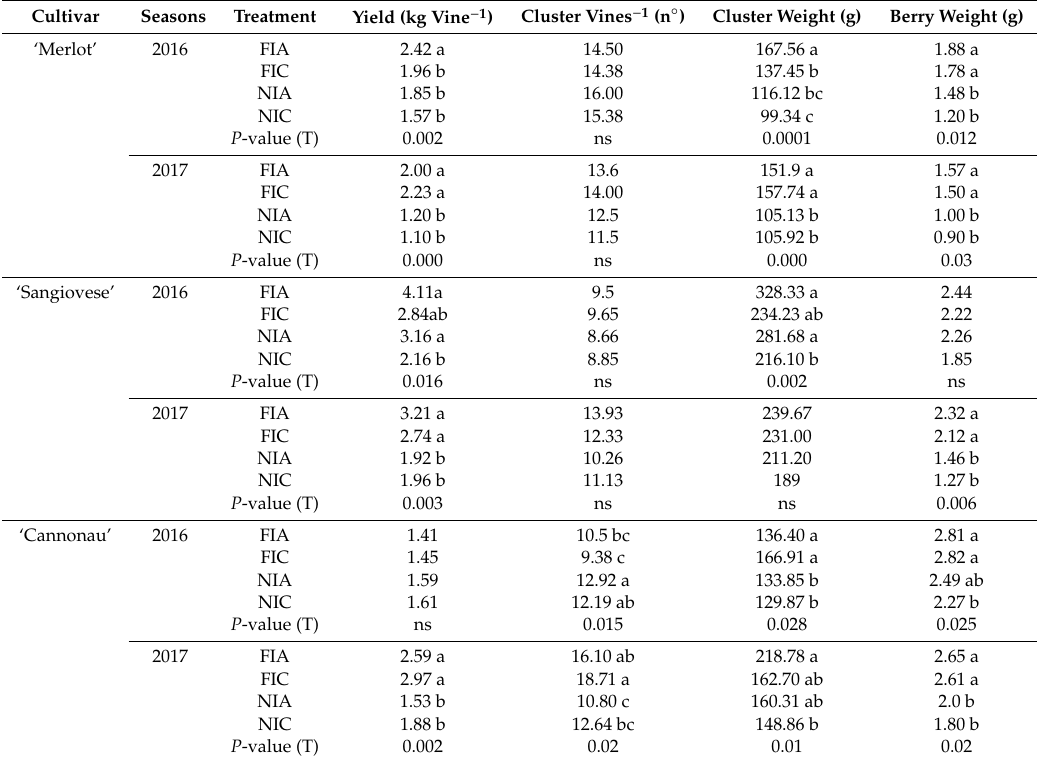
Table 3. E ff ect of irrigation and exogenous abscisic acid (ABA) treatments on yield and yield components in ‘Merlot’, ‘Sangiovese’ and ‘Cannonau’. FIA = full irrigation ( + ) ABA; FIC = full irrigation ( − ) ABA; NIA = no irrigation ( + ) ABA; NIC = no irrigation ( − ) ABA. Means within column / (cultivar season) followed by di ff erent letters were significantly di ff erent at P ≤ 0.05 using the LSD test. ns = not